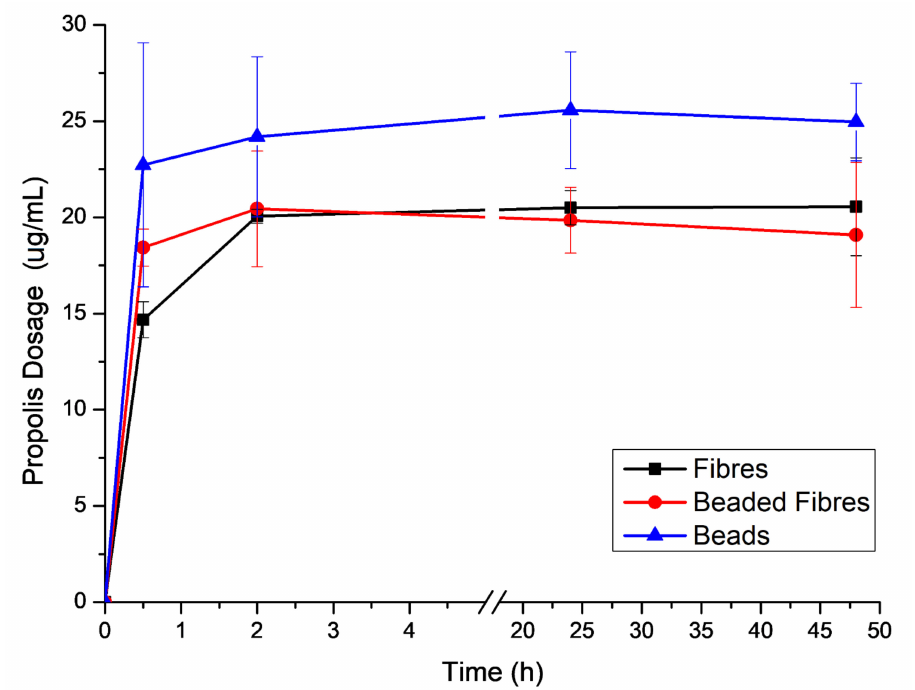
Figure 8. Propolis release profile in the function of the delivery time for the different